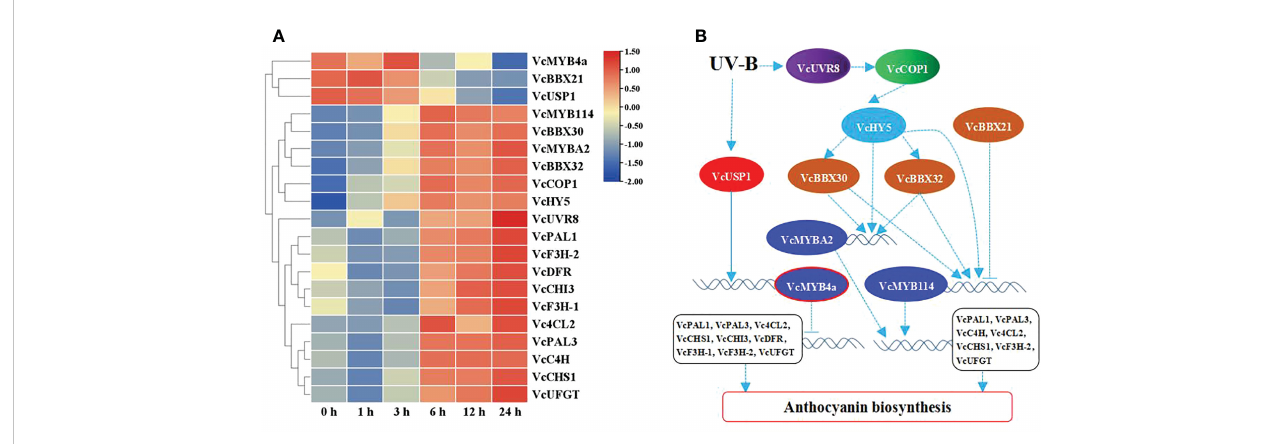
FIGURE 4 UV-B-induced anthocyanin biosynthesis pathway. (A) Heatmap representation of hierarchical clustering analysis of UV-B-induced anthocyanin biosynthesis pathway genes and transcription factor genes. Blue, low expression; red, high expression, based on log 10 (FPKM). (B) Proposed model of UV- B-induced anthocyanin biosynthesis pathways. Solid line indicates known signaling pathway; dotted line indicates putative signaling pathway. Arrows indicate activation; short lines indicate